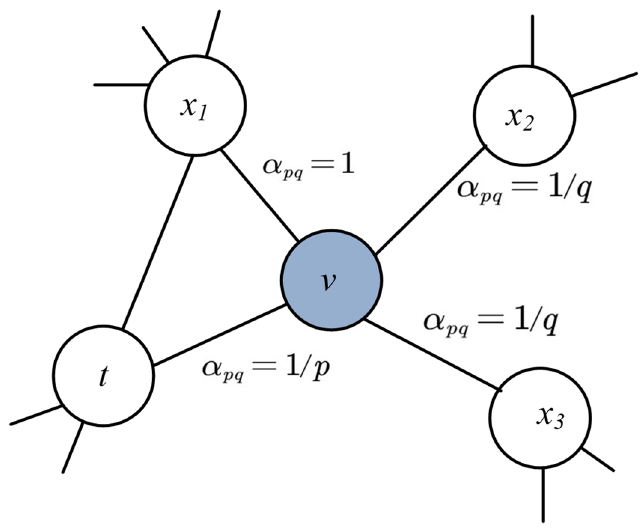
Figure 2. Biased random walk procedure in node2vec.